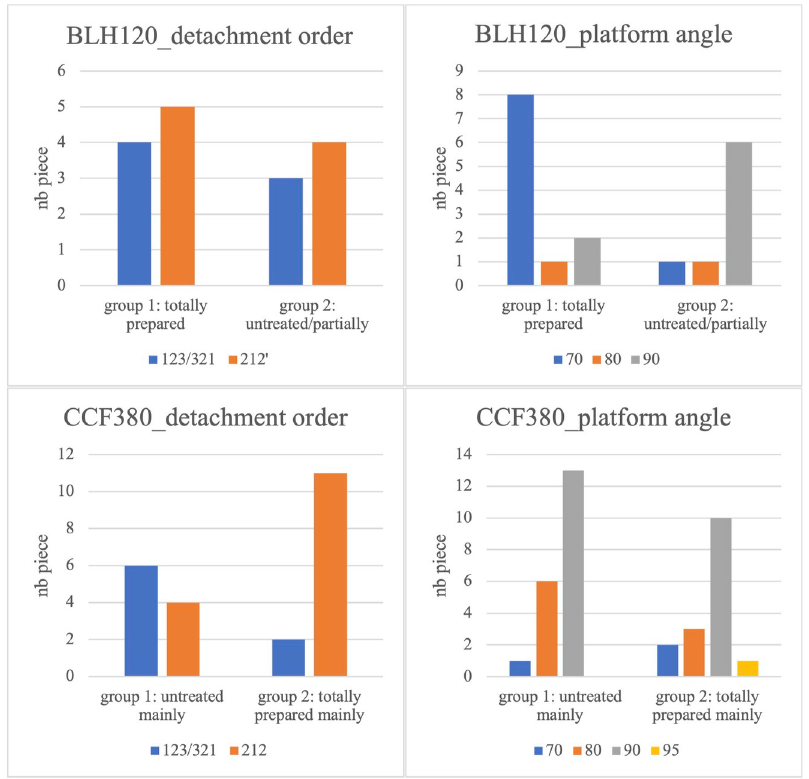
Fig 8. Histograms of codes (detachment order) and platform angles (in degrees) according to the different groups of blades.